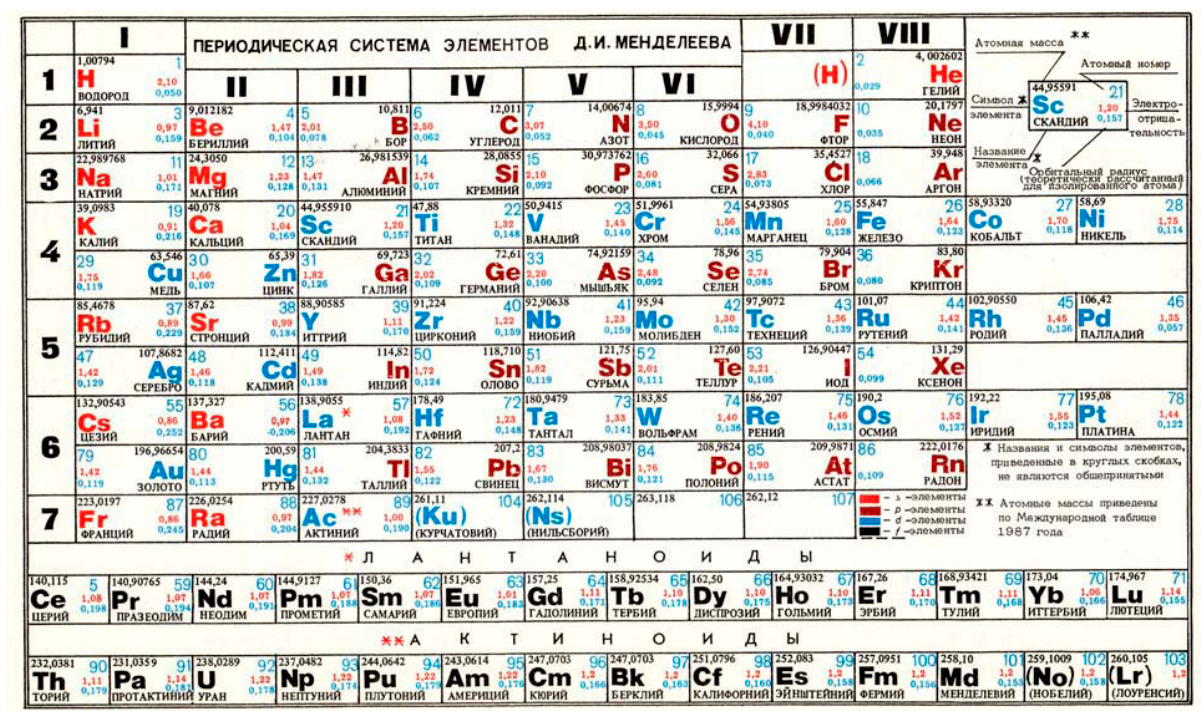
Figure 3. A Russian Periodic Table showing elements 104 and 105 as kurchatovium and nielsbohrium respectively. Courtesy of Mary and Jan Kochansky.